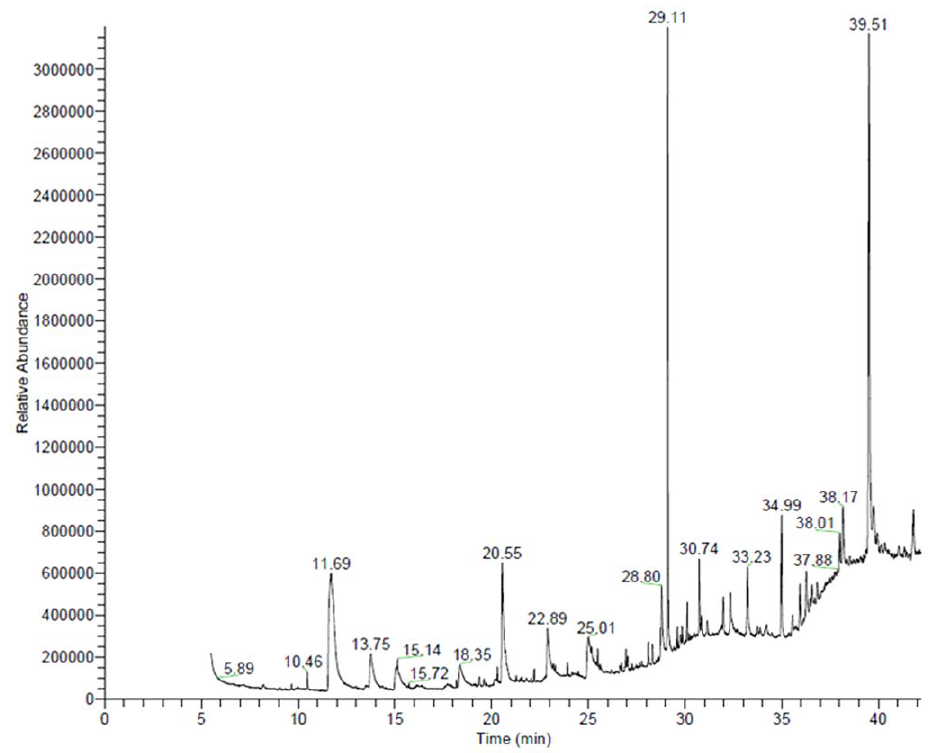
Figure 2. GC/MS chromatogram of chloroform root extract of R.imbricata .